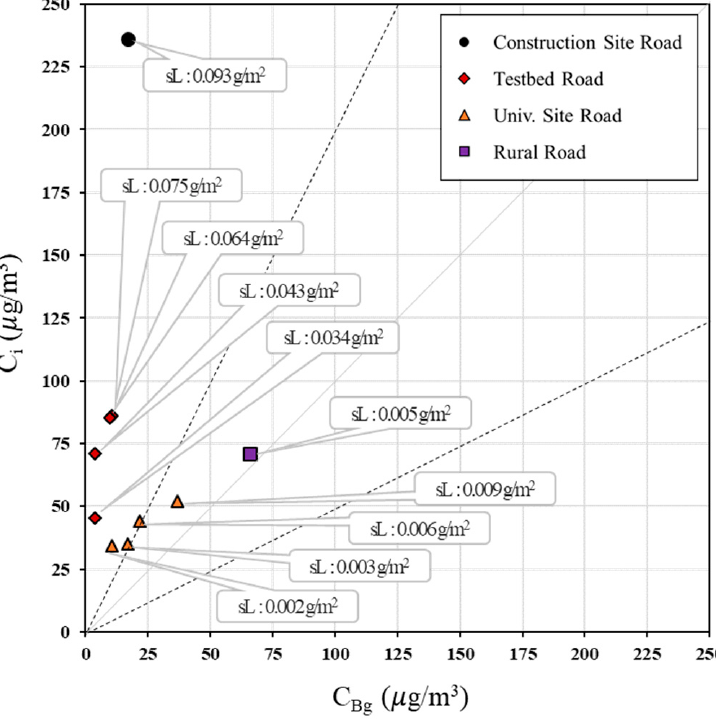
Figure 5. C Bg vs. C i concentration with sL in other measured sites.